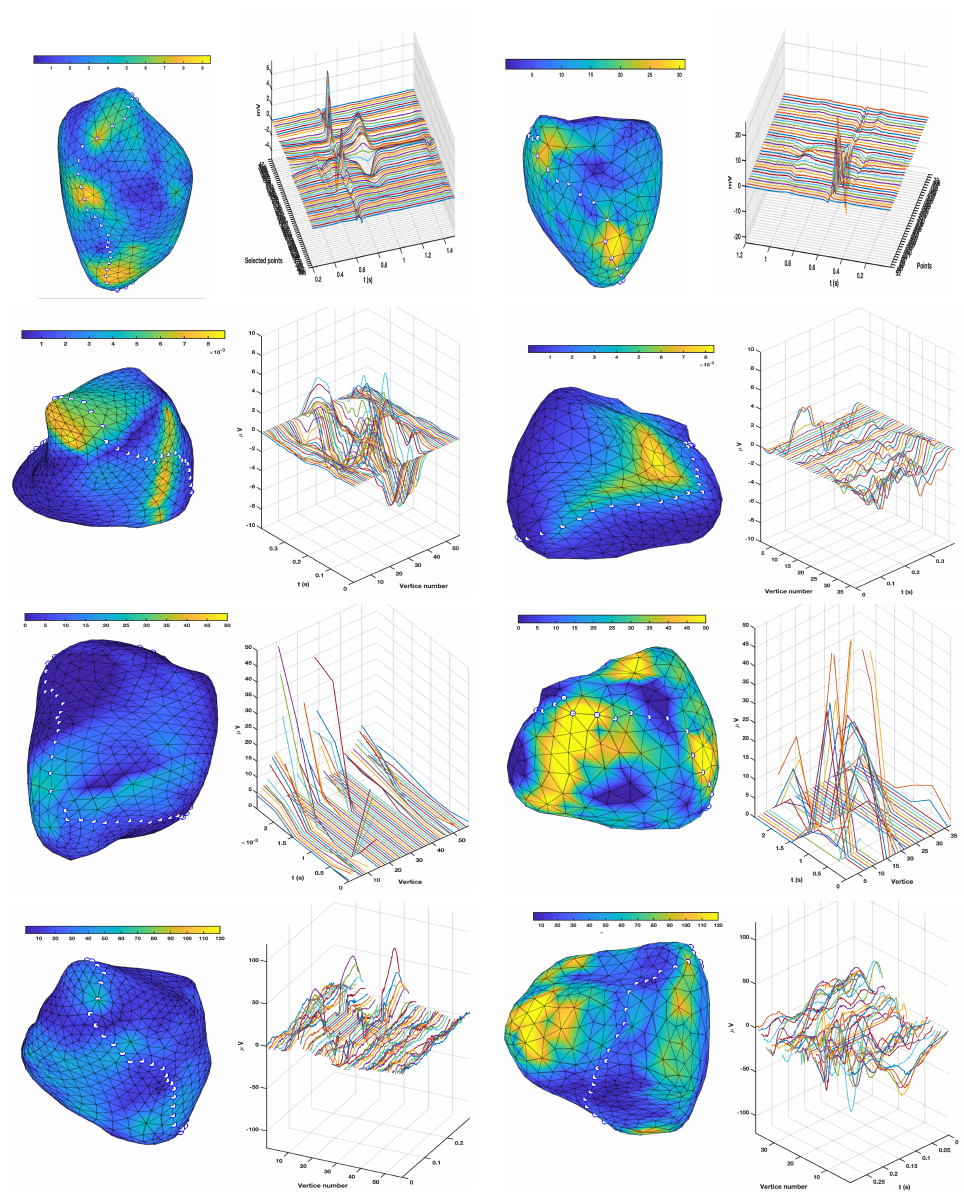
Figure 9. Analysis of TWA detection algorithms in epicardium recordings, for control subject ( left ) and LQTS patient ( right ). Content of panels is similar to Figure 8 but for epicardium instead of